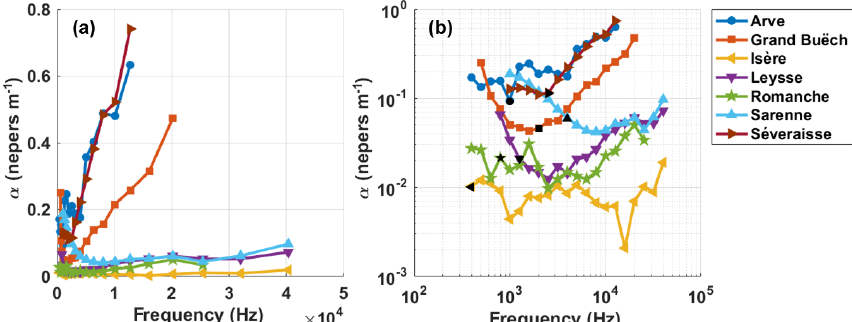
Figure 8. Attenuation coefficient ( α in nepersm − 1 ) obtained when using a cylindrical model of the geometrical spreading loss: (a) linear and (b) logarithmic scales. Black symbols indicate the cutoff frequency computed with Eq. (8), sound speeds of 1500 and 1600ms − 1 in the water and sediment layer, respectively. Table 2. Average results over frequency (1–10kHz) of the parameters of the fit using cylindrical geometrical spreading. River α Corr. coeff. of Residuals Maximum distance of the (nepersm − 1 ) the fit ( r 2 ) (dB) monitored chirps (m) Arve 0.26 0.5 11 Grand Buëch 0.08 0.7 31 Isère 0.008 0.4 Leysse 0.01 Romanche Sarenne 0.099 Séveraisse 0.215